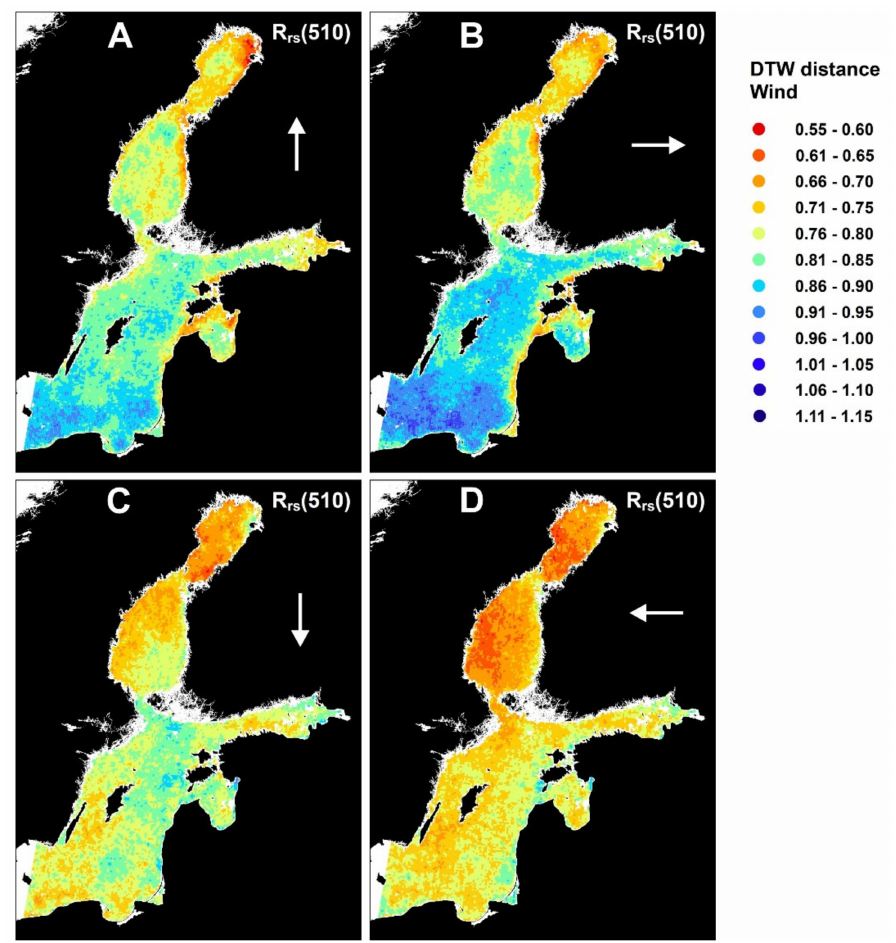
Figure 11. Time series distances from (standardized) wind components to R z (510). In reddish areas stronger winds were more closely followed by elevated reflectance than in blueish areas. ( A ) north wind, ( B ) east wind, ( C ) south wind, ( D ) west